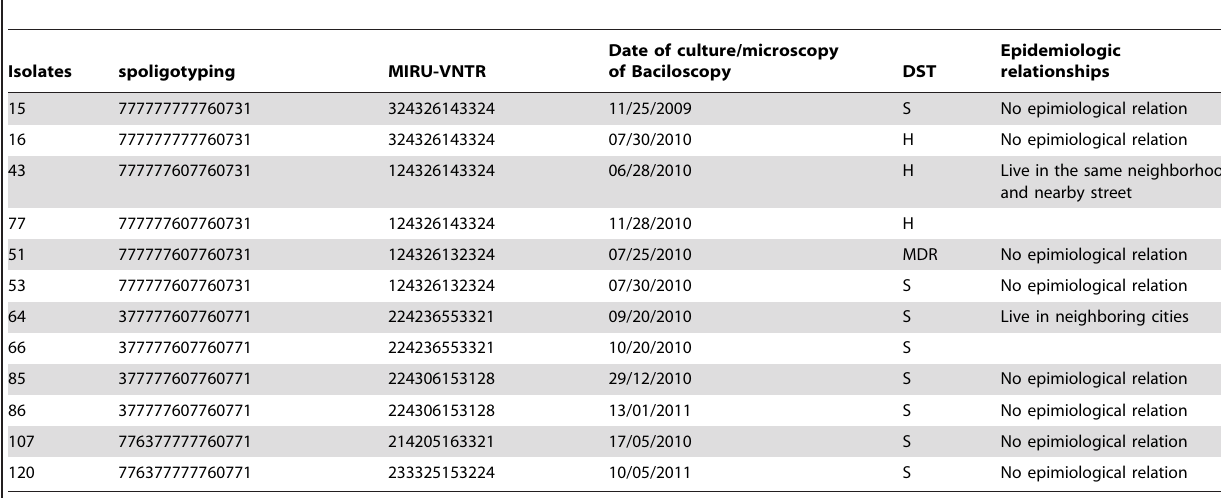
Table 3. Clusters by Spoligotyping/MIRU combination and epidemiological data of 12 Mycobacterium tuberculosis isolates from patients in cities in southwestern Parana´, Brazil.